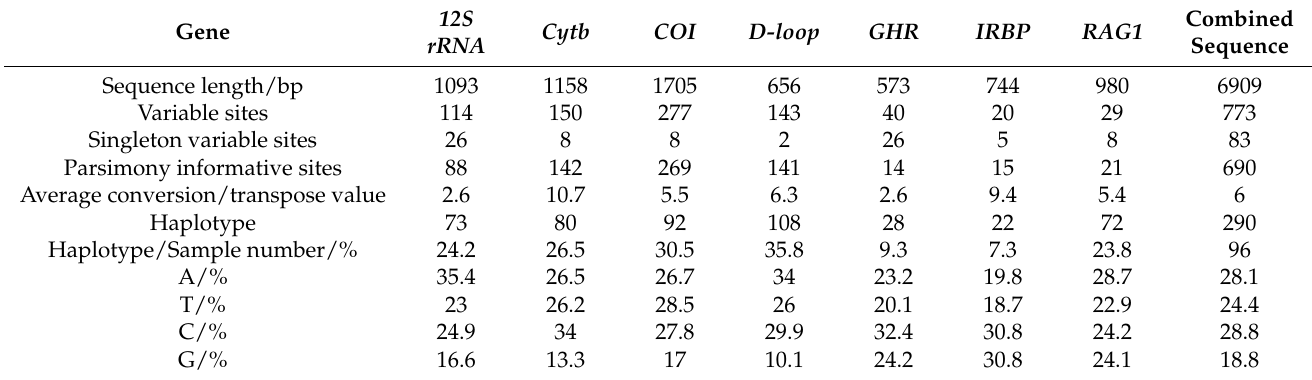
Table 3. Analysis of different gene sequences and total sequence variation.